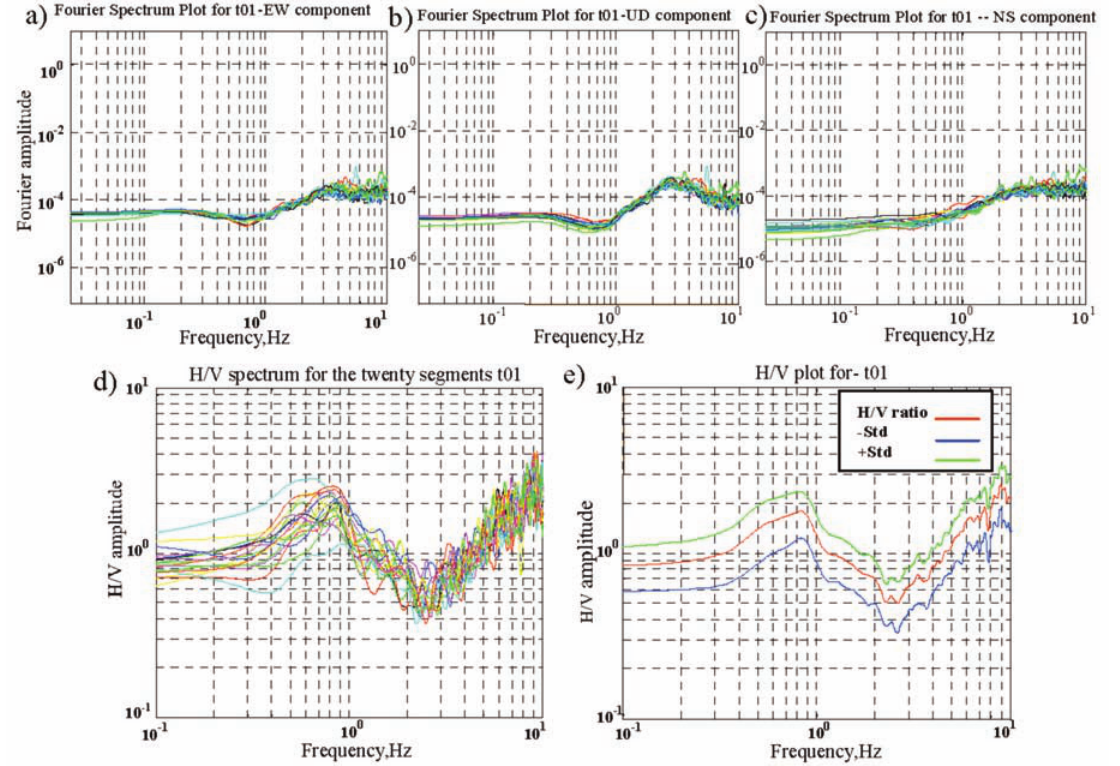
Figure 4. (a-c) Fourier spectra of horizontal and vertical components of microtremors. (d) The calculated Fourier spectral ratios related to he 20 windows. (e) The mean of the Fourier spectral ratios.